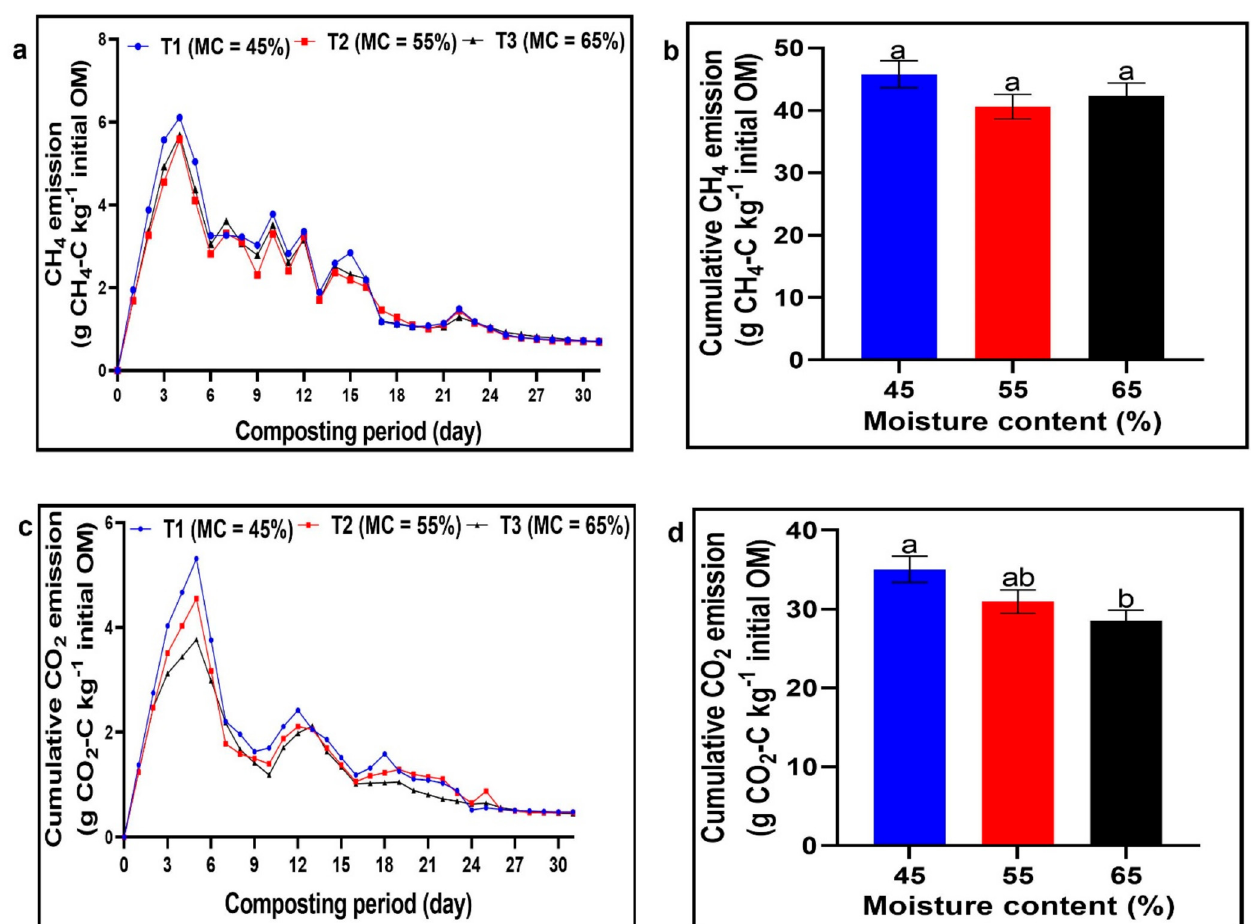
Figure 5. Temporal emission of methane ( a , b ) and carbon dioxide ( c , d ) gas during composting under different moisture